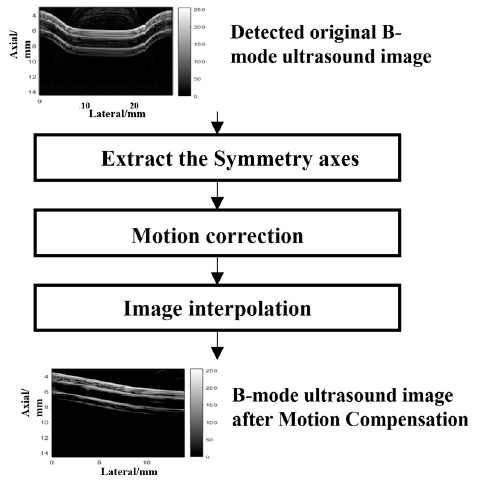
Figure 8. Schematic diagram of the process of motion compensation.